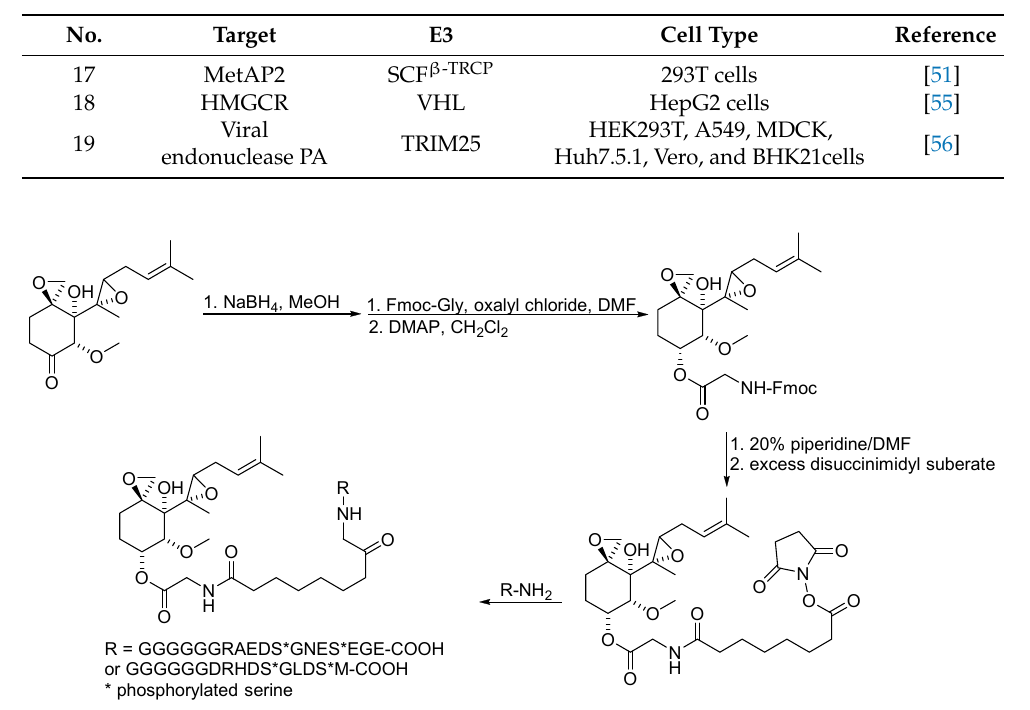
Table 8. Natural product targets 17–19.